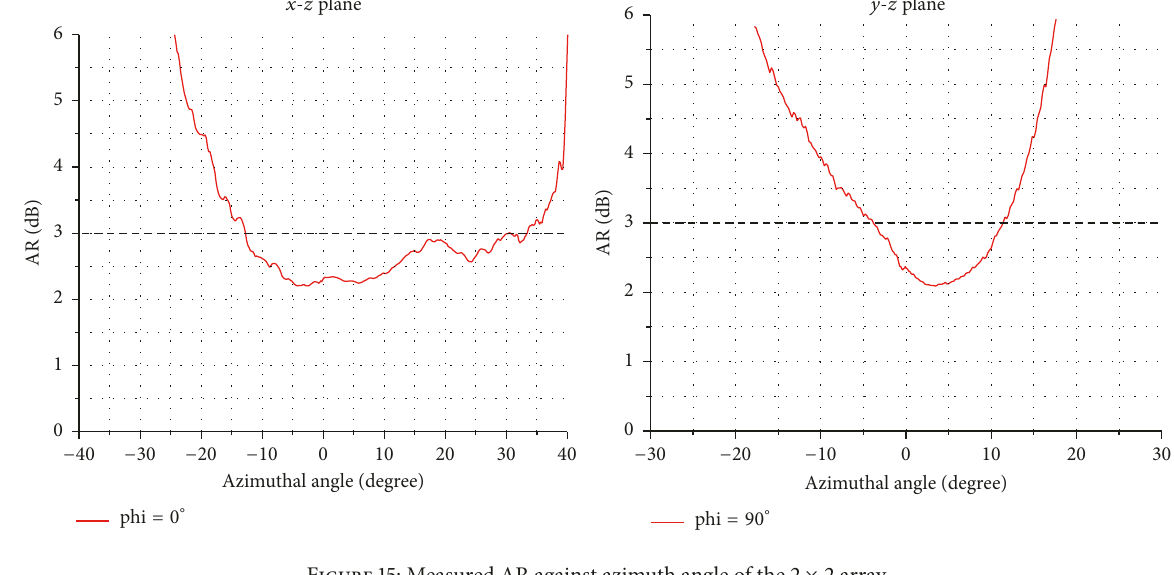
Figure 15: Measured AR against azimuth angle of the 2 × 2 array.